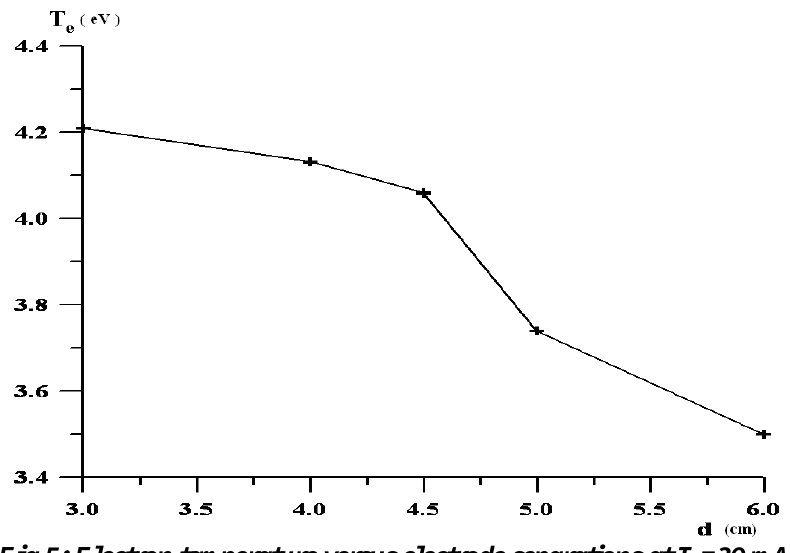
Fig.5: Electron temperature versus electrode separations at Id=30